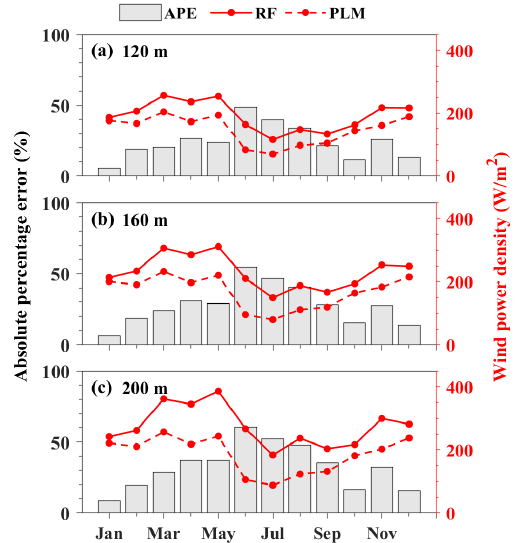
Figure 10. Similar to Fig. 9 but for the monthly